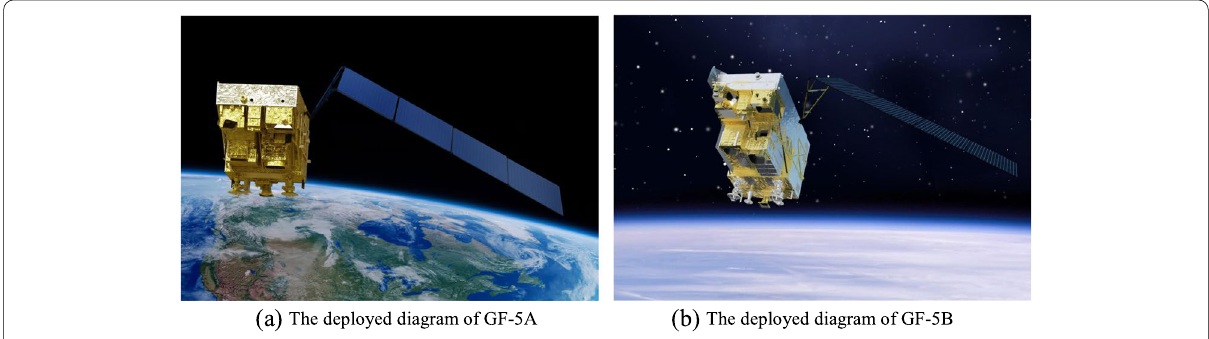
Fig. 5 Artist’s rendition of deployed GF-5A/B. a The deployed diagram of GF-5A. b The deployed diagram of